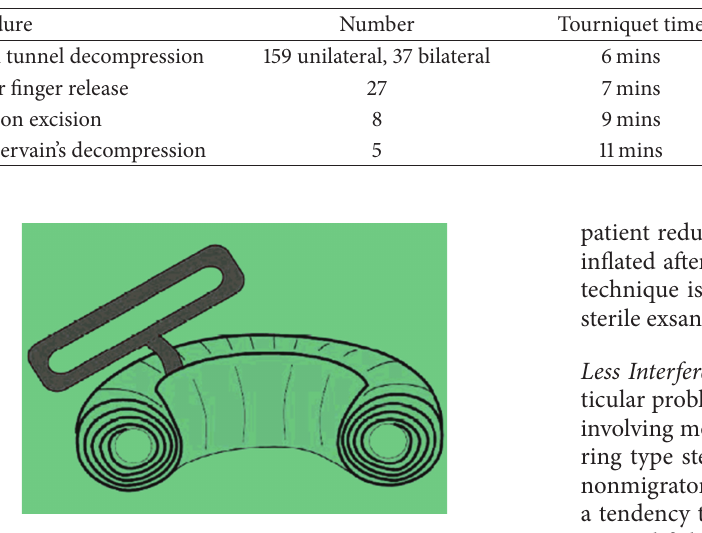
Table 1: Table of results.